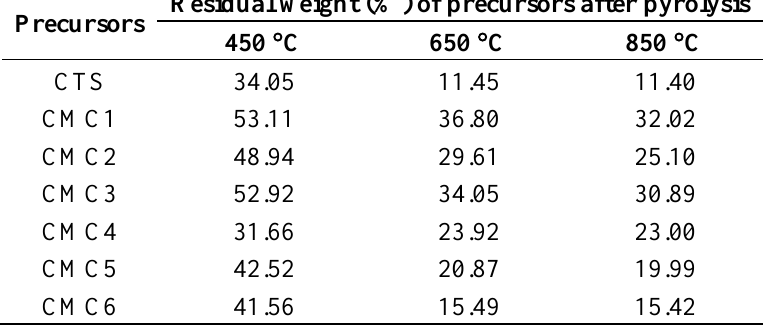
Table 2. Residual weight of zinc-chitosans organic polymers during TGA after different pyrolysis temperatures.